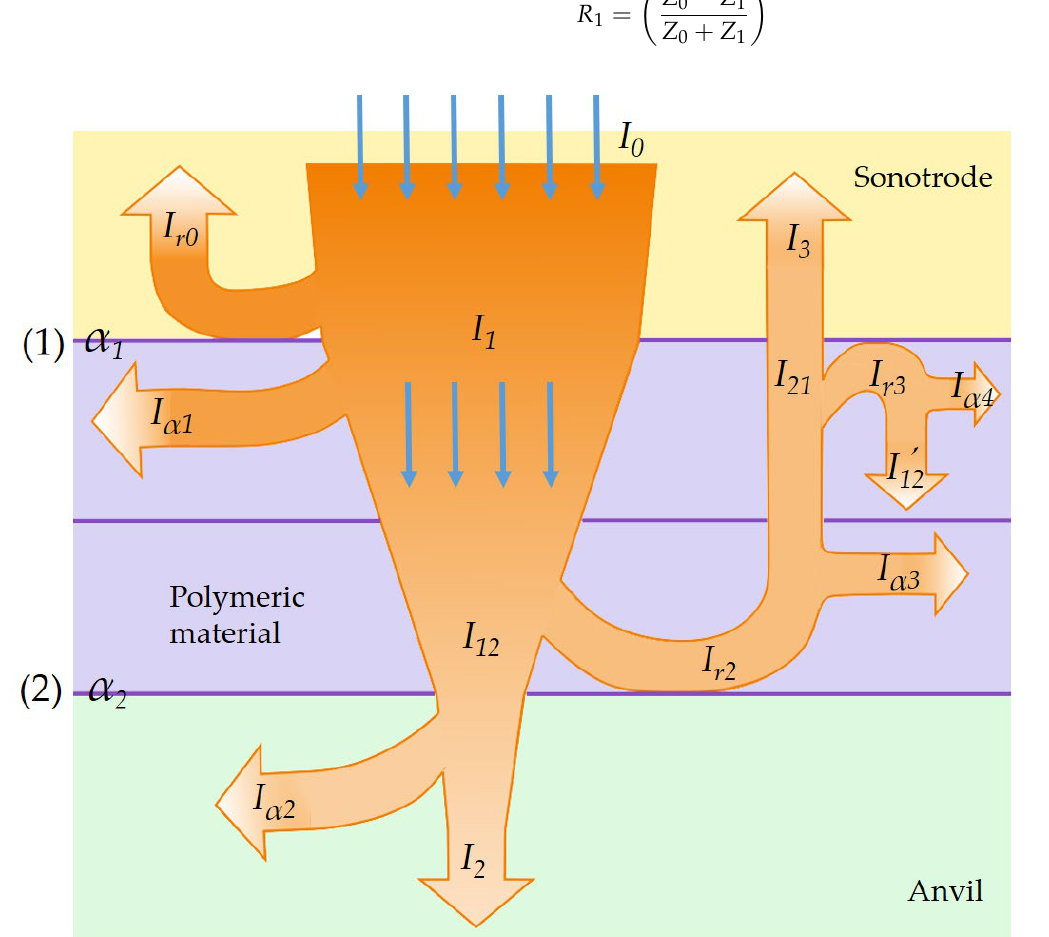
Figure 2. A symbolic author’s presentation of the intensity, propagation, reflection and absorption of ultrasonic waves, suitable for production engineering. ultrasonic waves, suitable for production